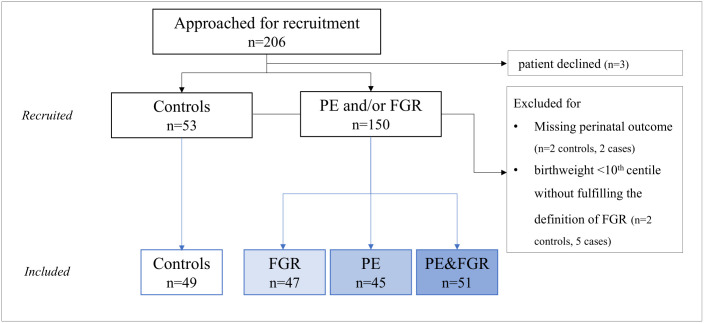
The flow chart of the study.FGR, fetal growth restriction; PE, preeclampsia.